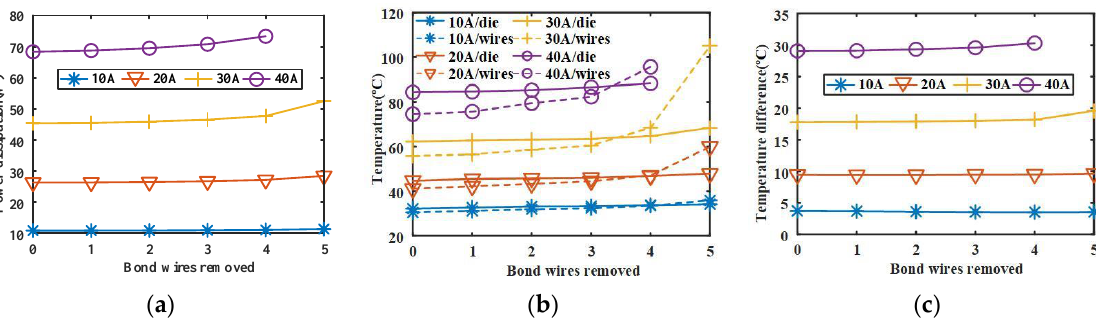
Figure 14. Measured results after bond wires removed ( a ) Power dissipation of IGBT module ( b ) Temperature of die and bond wires ( c ) Temperature difference between die and case.